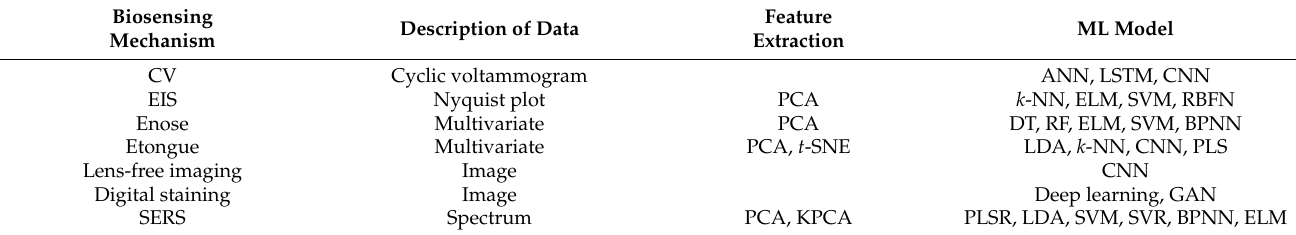
Table 2. Summary of data types and useful ML methods for biosensing